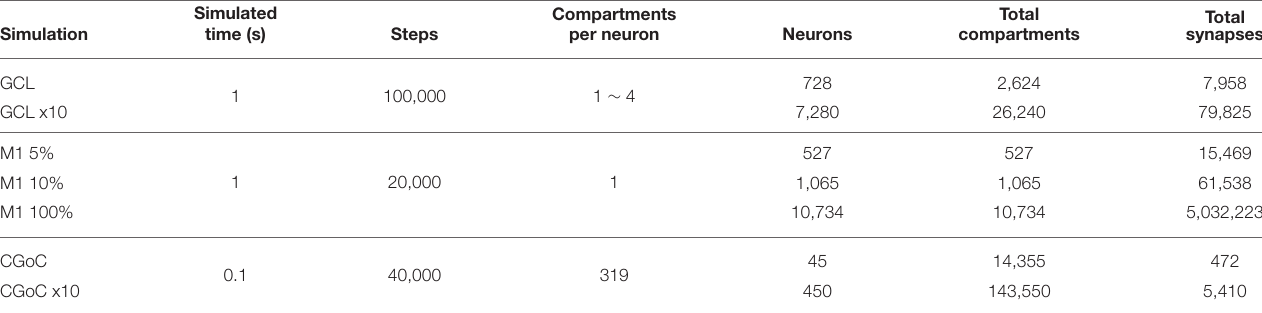
TABLE 2 | The simulated networks used for performance